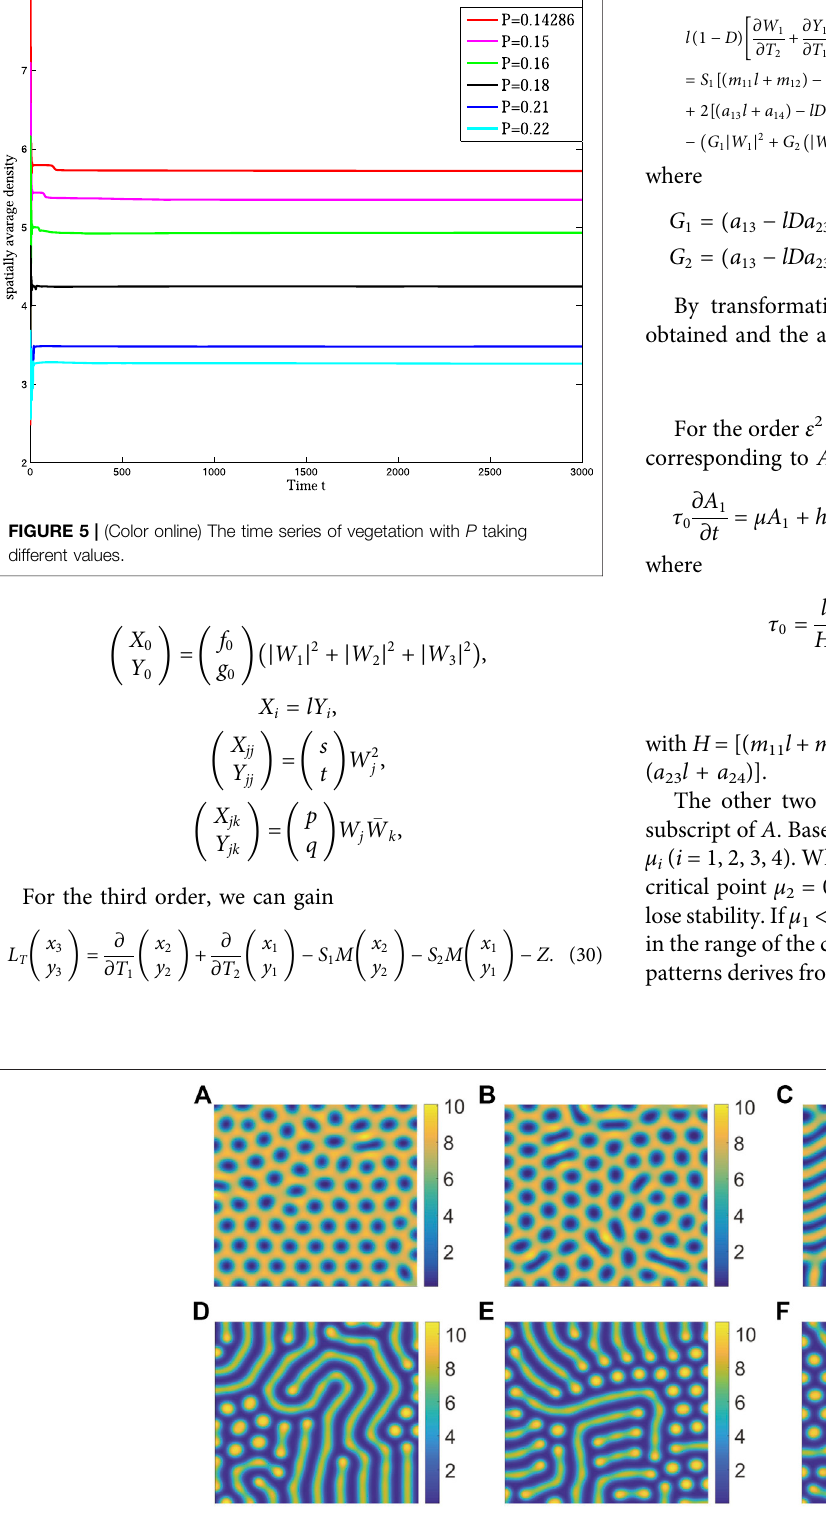
FIGURE 6 | Snapshots of the countour pictures of evolution of vegetation with different values of P , (A) p (cid:1) 0.16; (B) p (cid:1) 0.17; (C) p (cid:1) 0.18; (D) p (cid:1) 0.23; (E) p (cid:1) 0.238; (F) p (cid:1) 0.25. The other parameters are taken as S (cid:1) 10.5, B (cid:1) 5, and D (cid:1) 30.